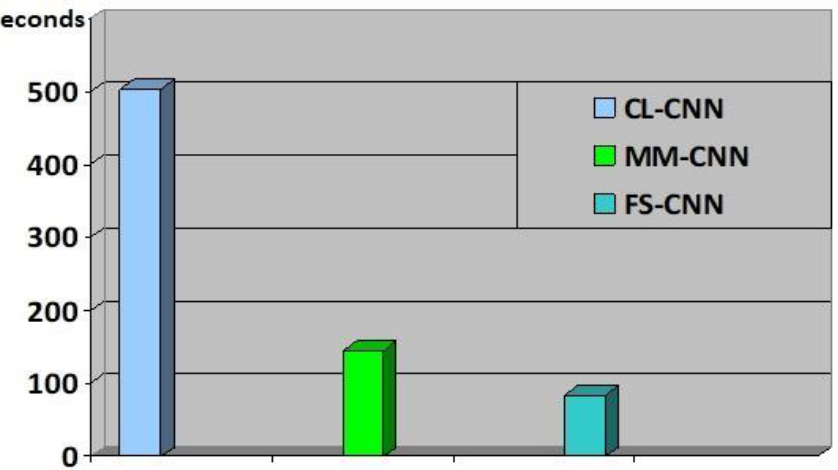
Figure 5. The time consumption of computing CNN activations with different CNN architectures for all SAR images in the MSTAR dataset.